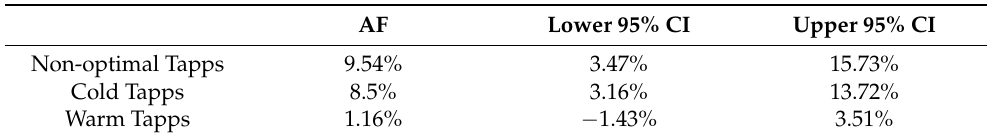
Table 1. The attributable fraction of CVD hospital admissions (N = 3124) from the two hospitals during the study period due to non-optimal cold and warm T app . The lower and upper 95% confidence intervals (CI) are